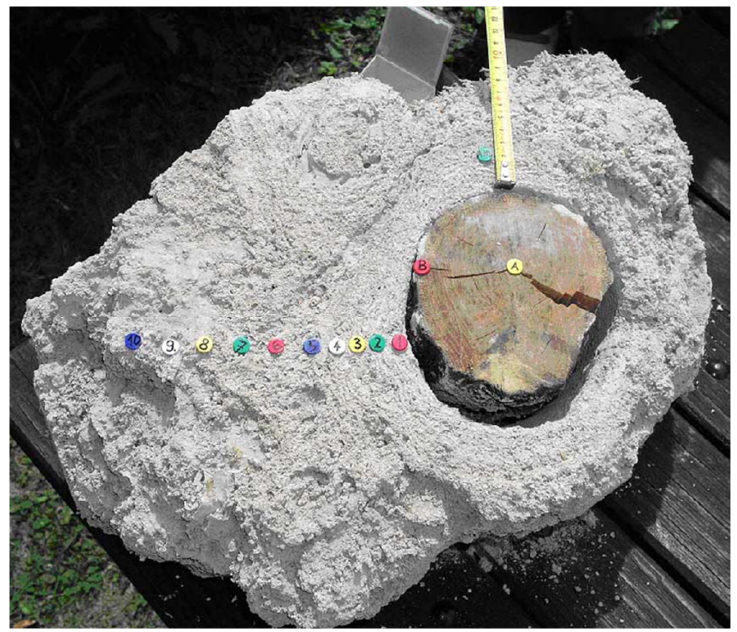
Figure 2. Tufa layer around the wooden pillar taken from the Korana River. Labels from 1 to 10 mark places of tufa sub-sampling. (Letters A and B refer to inner and outer wood layers). Table 1. Labels of sampled layers, distance from the beginning of the tufa growth and year assigned to each layer, assuming linear tufa